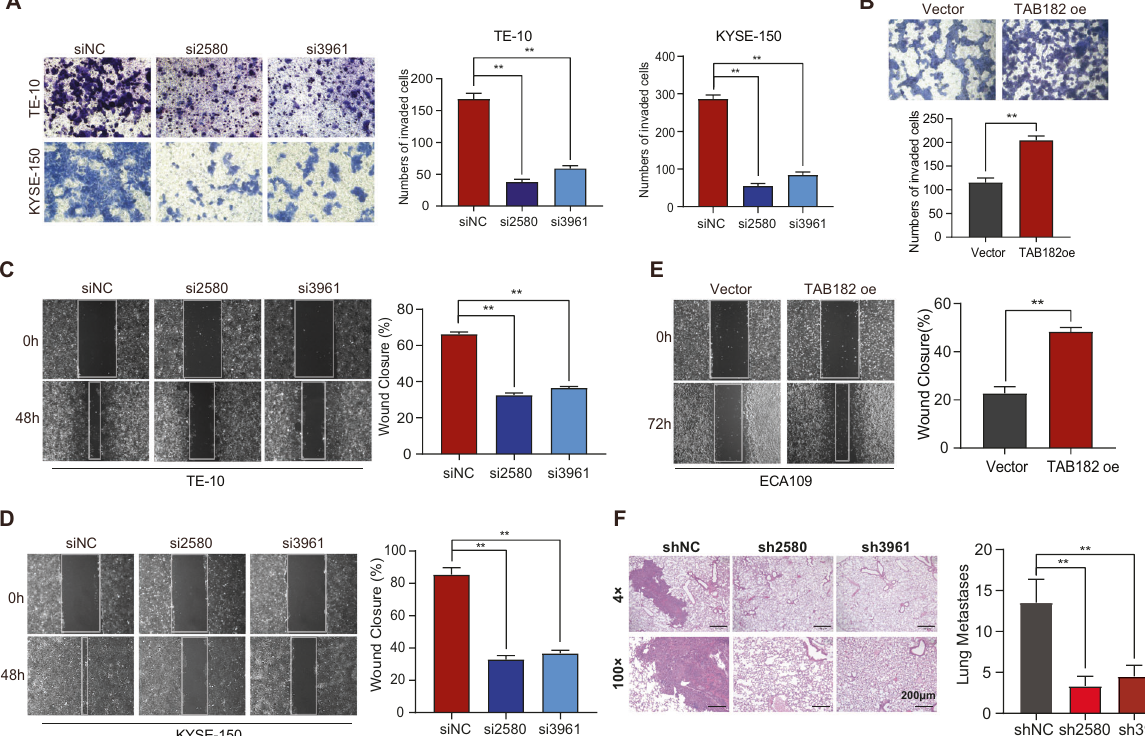
Fig. 2 Down-regulation of TAB182 inhibits ESCC cells invasion and metastasis. A knockdown of the expression of TAB182 inhibited the invasion of TE-10 cells and KYSE-150 cells. B over-expression of TAB182 promoted the invasion of ECA109 cells. All groups started with the same cell numbers; cell numbers were counted after 24 h. C , D knockdown of the expression of TAB182 inhibited the migration of TE-10 cells and KYSE-150 cells. E over-expression of the expression of TAB182 enhanced the migration of ECA109 cells. The change in wound area was recorded daily with ImageJ software at 24, 48 and 72 h. The data were a representative of three repeats. Error bars indicate mean ± S.E.M. ** P < 0.01, student t-test. F the metastasis of KYSE cells was assessed by the number of lung metastatic nodules 30 days after injection of cells through the tail vein of the mice. **, p <